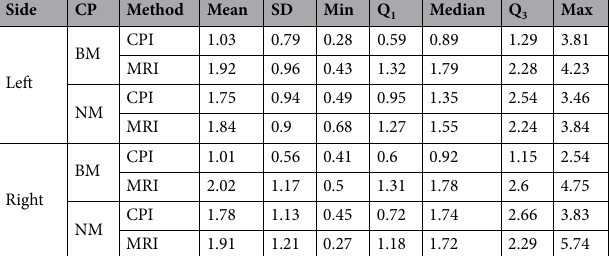
Table 2. Descriptive statistics for left and right 3D Euclidean distances of bimanually manipulated (BM) and neuromuscular (NM) condyle positions in millimeters, separately for CPI and MRI (n = 20). Abbreviation: CP condylar